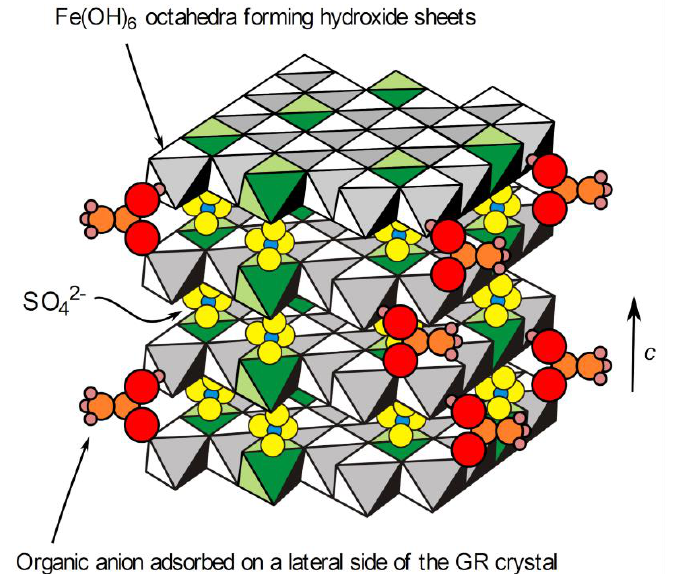
Figure 8. Schematic representation of a GR(SO 42 − ) crystal with adsorbed acetate ions. The interlayers are actually composed of two layers of SO 42 − ions and include water molecules that were omitted for clarity. The octahedra in green are those built on Fe(III) cations.